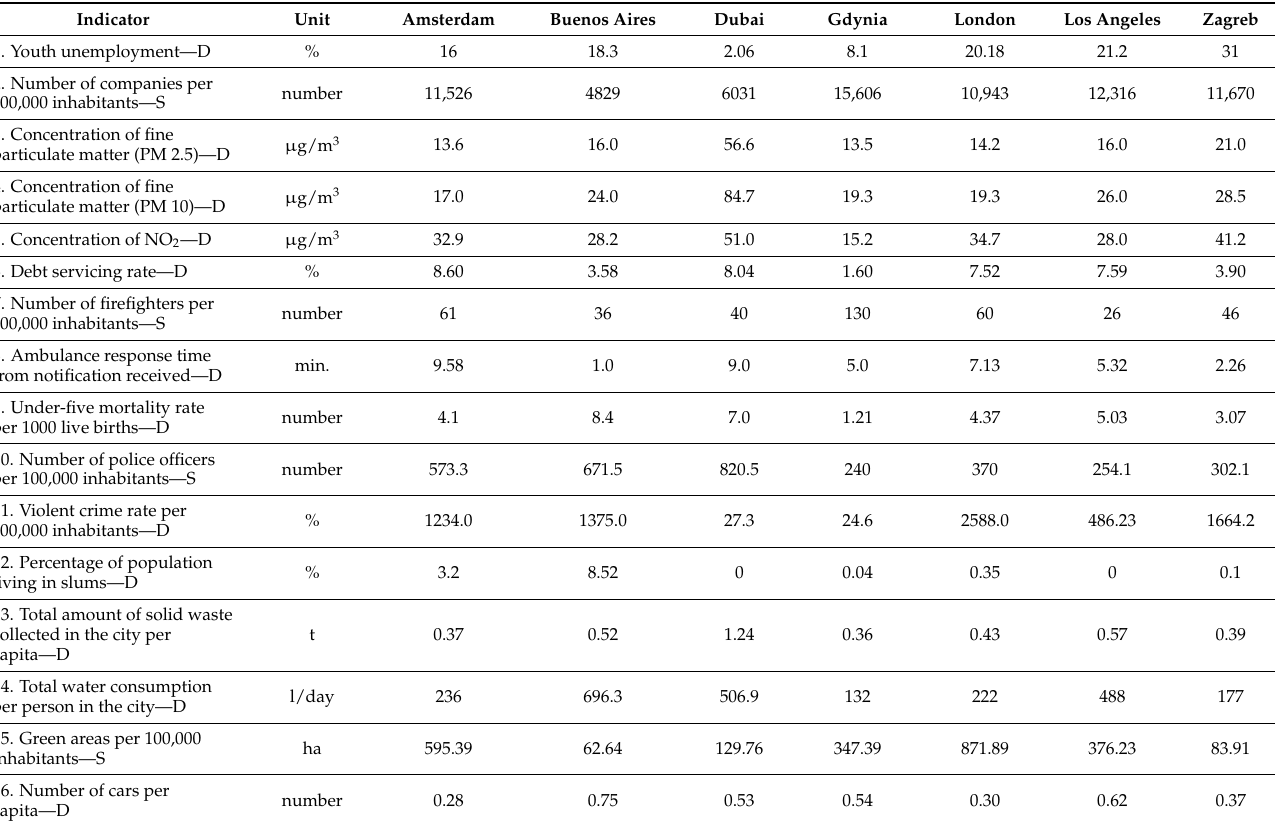
Table 2. Indicators as per the ISO 37120 standard applied in the analysis with regard to the selected